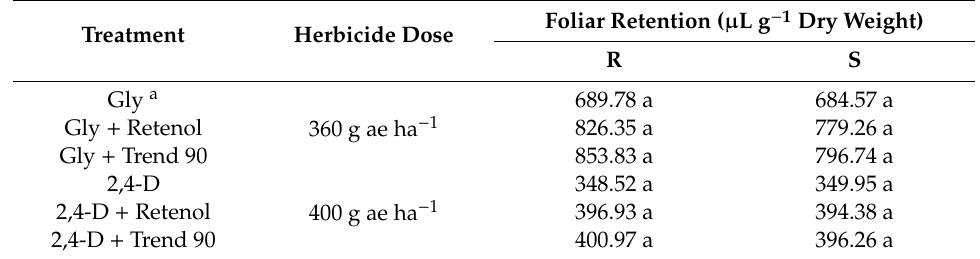
Table 3. Foliar retention of glyphosate and 2,4-D with and without adjuvants and increased e ff ectiveness